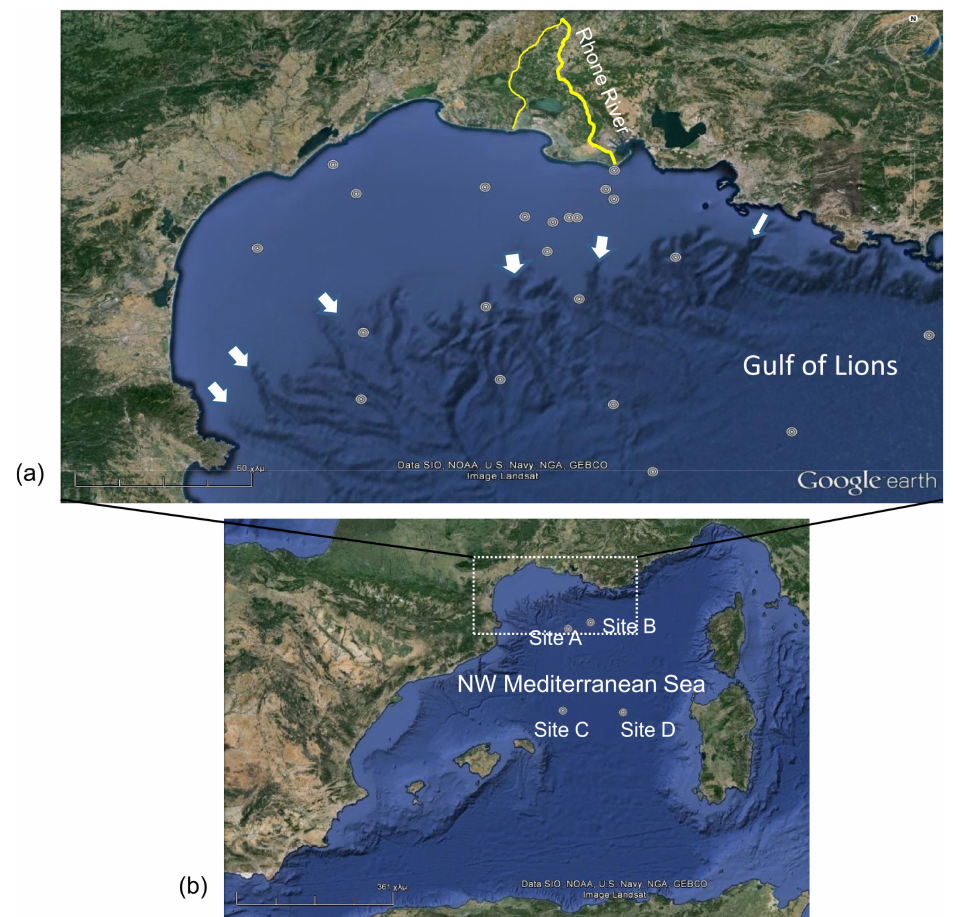
Figure 4. The Gulf of Lions ( a ) and the NW Mediterranean Sea ( b ). The stations sampled for surface sediments during the EROS-2000 project are shown with white dots. At sites A, B, C, D with depths > 2000 m short sediment cores were collected. The arrows indicate the positioning of the submarine